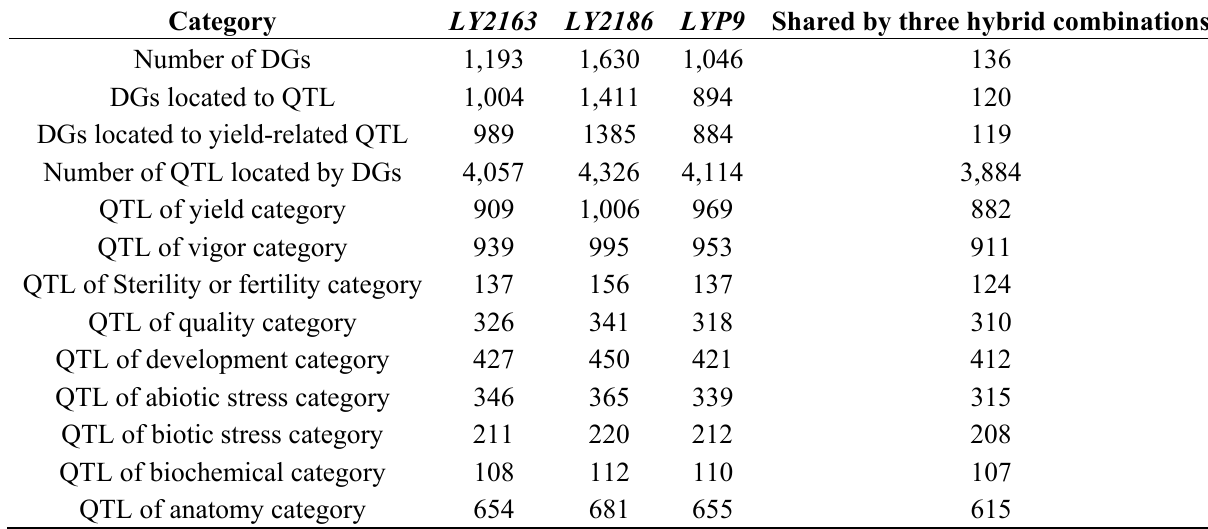
Table 3. Correlations between DGs a and quantitative trait locus (QTL) b in the three hybrid rice